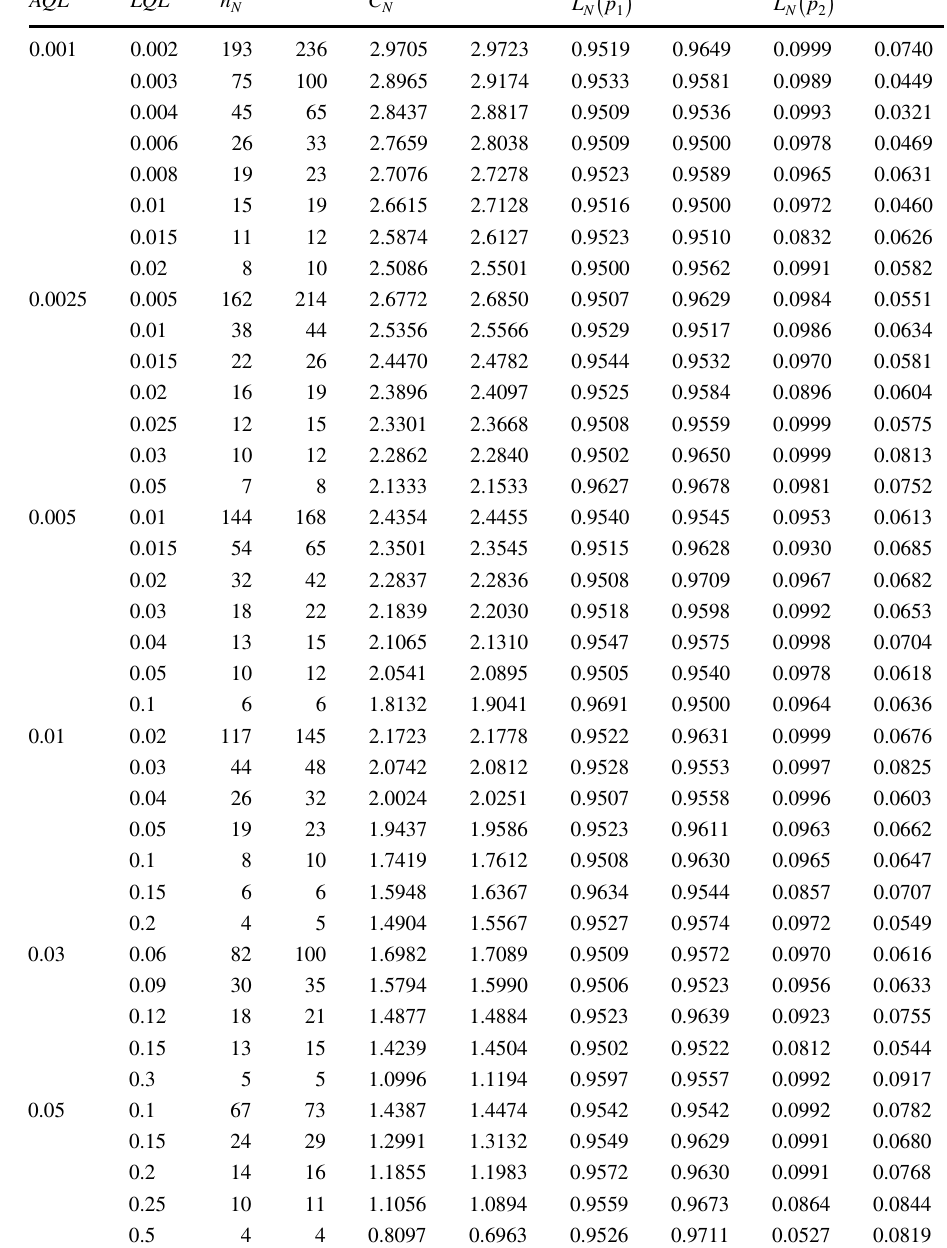
the existing neutrosophic plan, when 𝜎 Y N is known